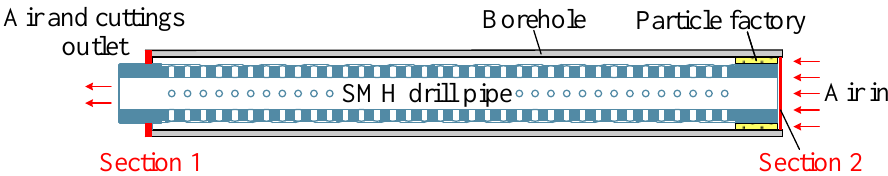
Figure 5. Geometric model of an SMH drill pipe in a borehole.